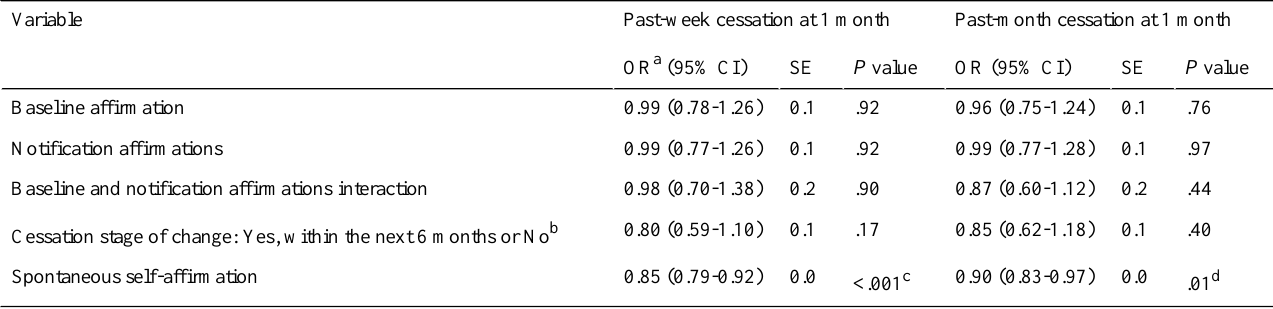
Table 3. Primary self-affirmation regression models